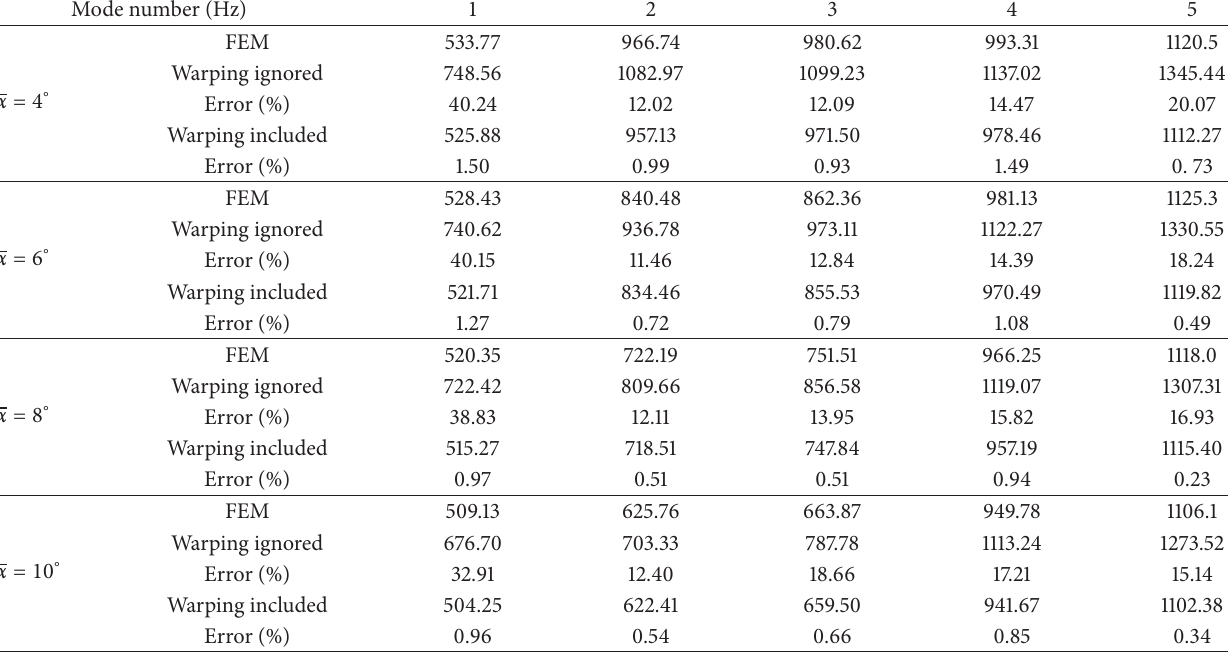
Table 6: Change law of the warping effect on natural frequencies with respect to the helix pitch